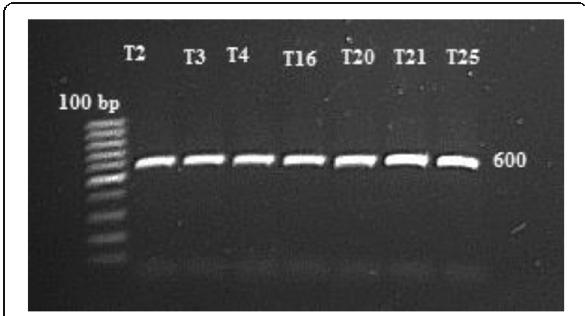
Fig. 2 DNA profile generated by ITS primers with Trichoderma